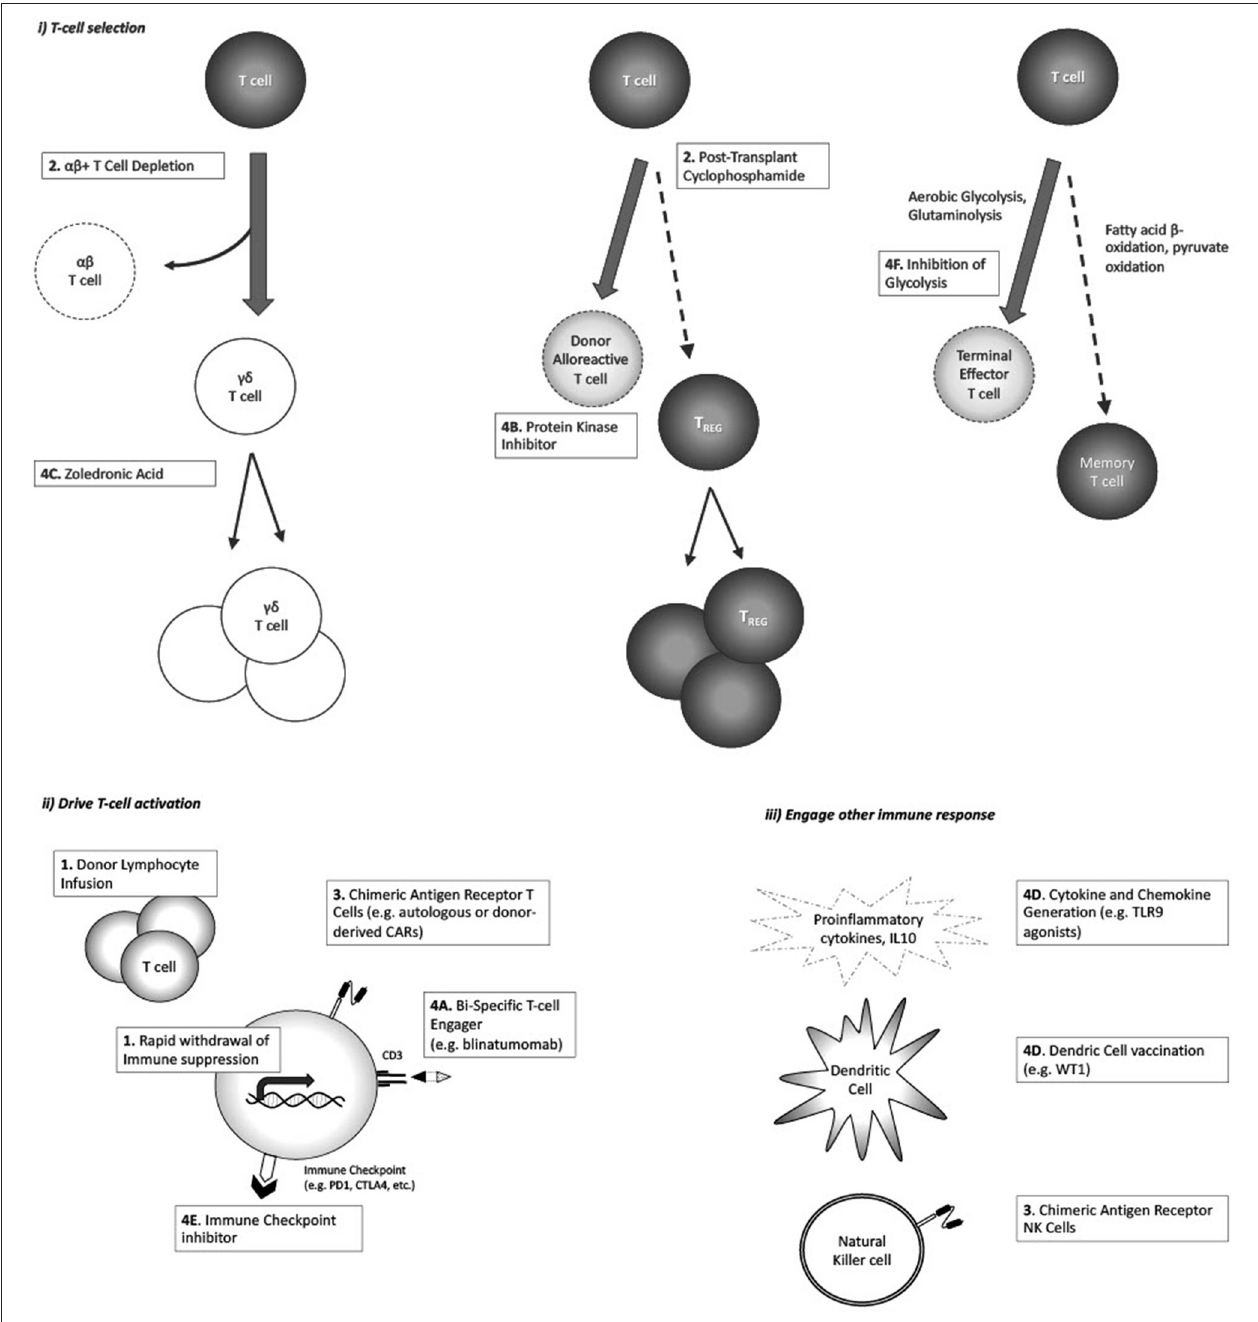
FIGURE 1 | Strategies postulated to augment GVL response, and/or enhance GVL without increasing GvHD: (i) Enhance selective T-cell populations; (ii) Drive T-cell activation against tumor antigen; (iii) Engage non-T-cell immune